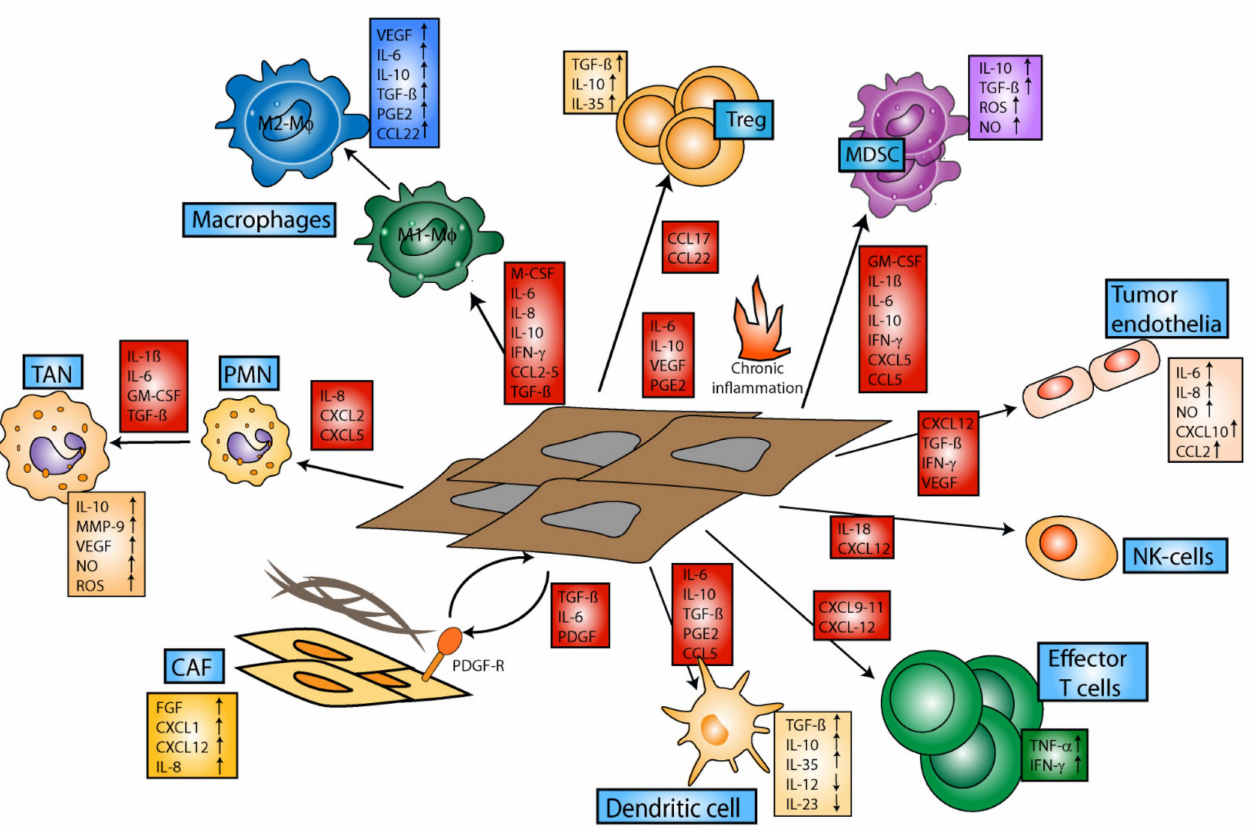
Figure 1. Tumor-induced immune modulation within the tumor microenvironment. Tumor cells secrete various cytokines, chemokines and soluble factors that generate a chronic inflammatory state within the TME that favors the accumulation of immunosuppressive cell types and impairs effector T cell function. Additionally, both immunosuppressive and effector immune cells, as well as non-immune cells such as cancer-associated fibroblasts and endothelial cells, contribute to the maintenance of this inflammatory micromilieu, hampering an effective anti-tumor immune